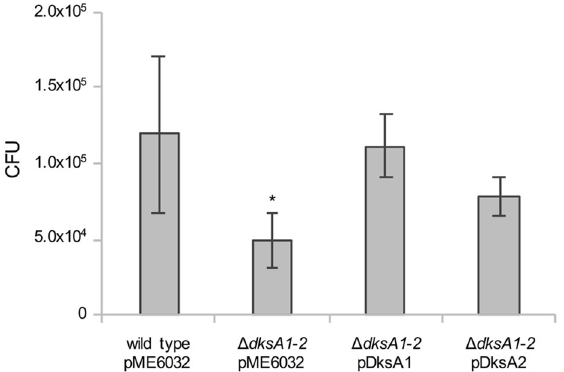
Figure 3. Intracellular survival of P. aeruginosa strains in RAW macrophages. Macrophages were infected for 30 min with the indicated strains, treated with gentamycin and lysed. Total live bacteria in cell lysates were recovered and quantified by CFU counts on PIA plates. The average CFUs per well from four independent experiments, each in duplicate, are reported with standard deviations. * p < 0.05 versus wild type